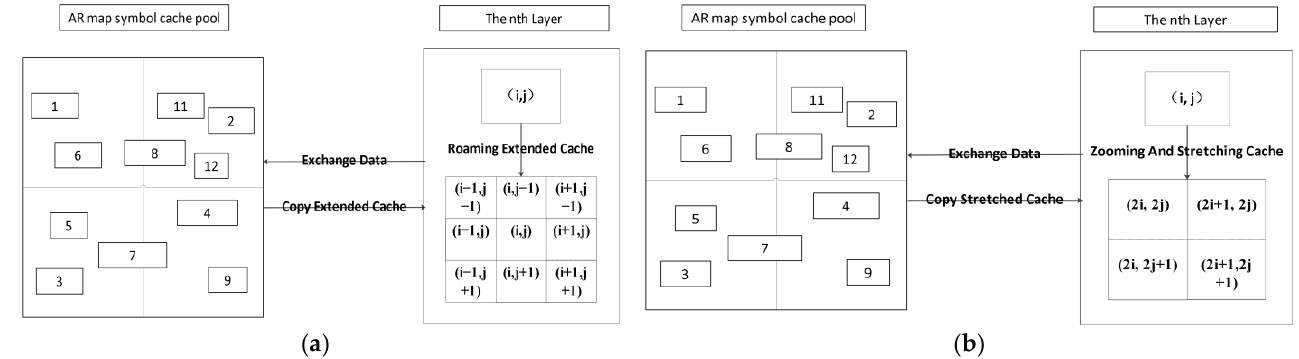
Figure 4. AR map symbol caching mechanism: ( a ) data extending and ( b ) data stretching caching mechanisms.